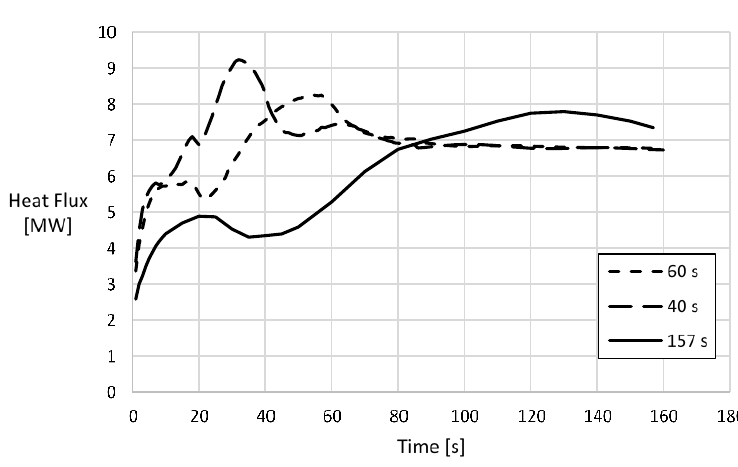
Figure 13. Convective heat flux evaluated on the control surface A for the three different opening of 40 s, 60 s and 157 s.